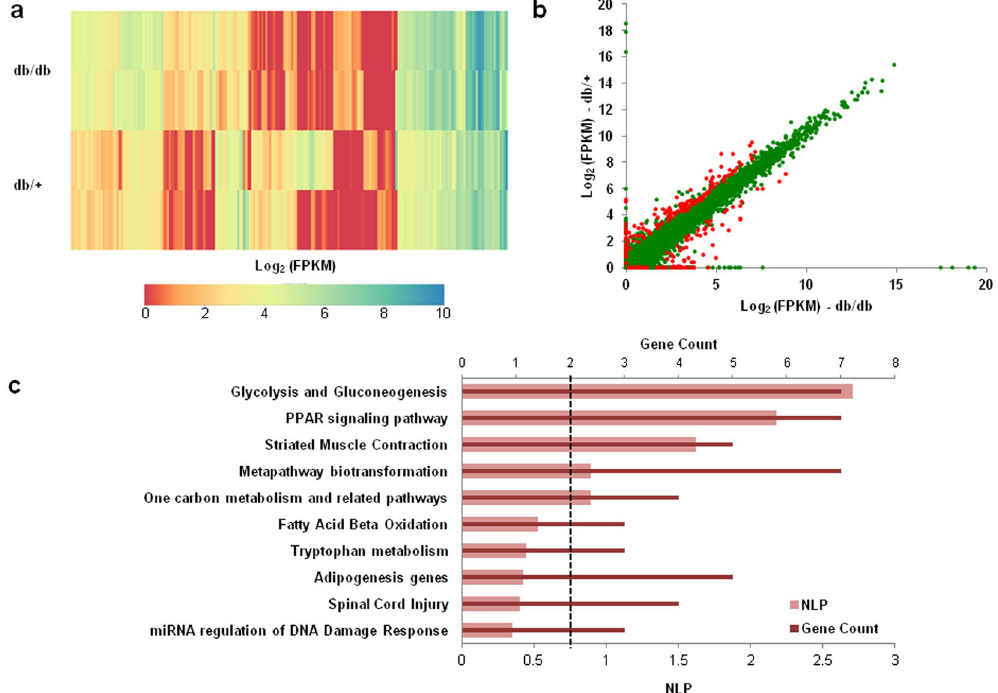
Figure 2. Representation of differentially expressed genes in the db/db mice liver. ( a ) Heatmap representing the expression pattern of 218 differentially expressed genes (as obtained from RNA sequencing) in the livers of diabetic (db/db) mice as compared to those of normal (db/ + ) mice. ( b ) Scatter plot comparing the mean expression profiles of all genes with FPKM > = 1 in at least one sample within normal and diabetic mice liver. The significantly differentially altered genes (218) have been highlighted in red color, while the remaining are indicated in green color. ( c ) Bar plot summarizing the results of pathway enrichment analysis for the differentially expressed (DE) genes. The figure plots NLP (Negative Log10 of the Bonferroni-adjusted P-value) as well as the overlapping gene count for each pathway. The black vertical dotted line denotes a minimum gene overlap count cutoff of